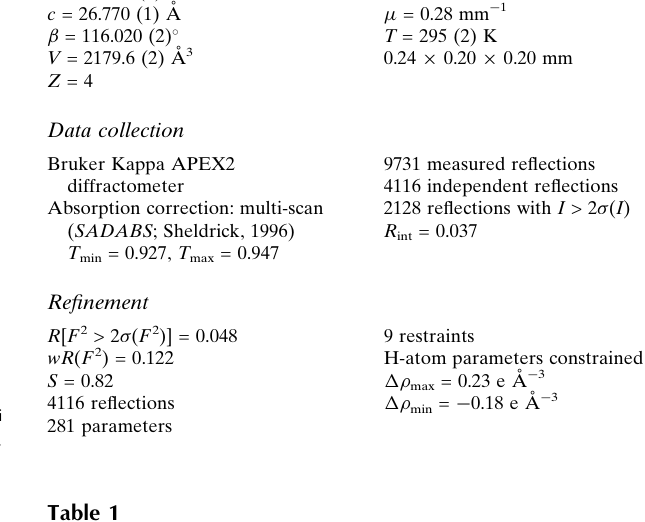
Hydrogen-bond geometry (A˚ , (cid:1)